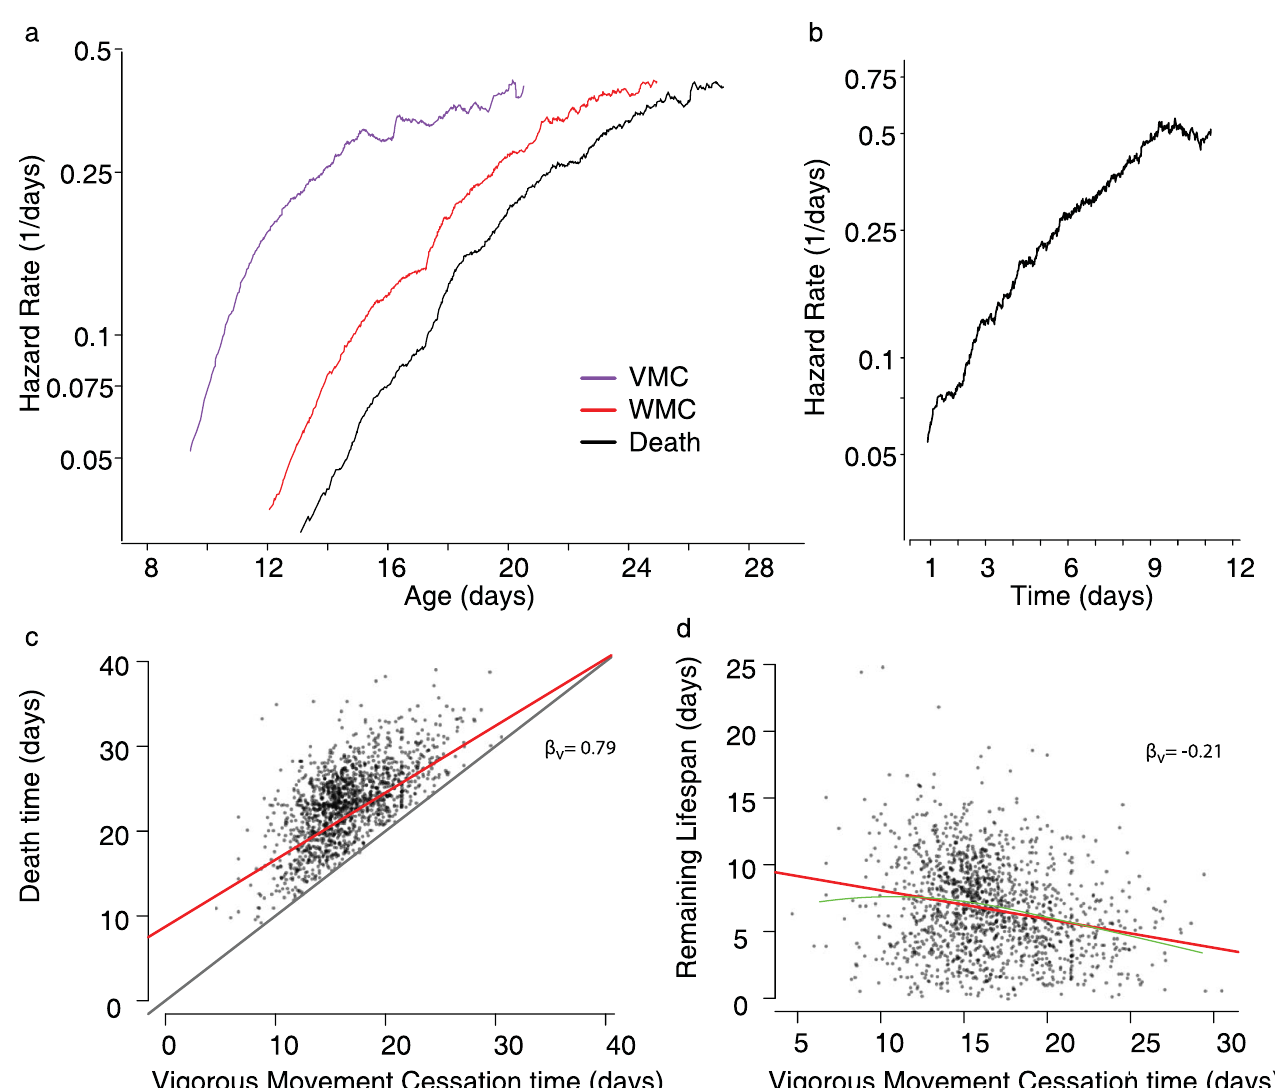
Fig 2. Relating vigorous movement and lifespan in wild-type populations. a. In a population of 1441 wild-type C . elegans housed at 20˚C, the risk of animals vigorous movement cessation (VMC) (purple), weak movement cessation (WMC) (red), and the risk of death (black) are shown in respect to chronological age. b. The "clock-reset" hazard estimates the risk individual’s death as a function of the time spent alive after VMC. c. The relationship between each individual’s VMC and death times are shown, with the linear regression line (red) and unit line y = x (black) overlaid. d. The relationship between VMC and the lifespan remaining after VMC, with the linear regression line (red) and LOESS regression line (green) overlaid.